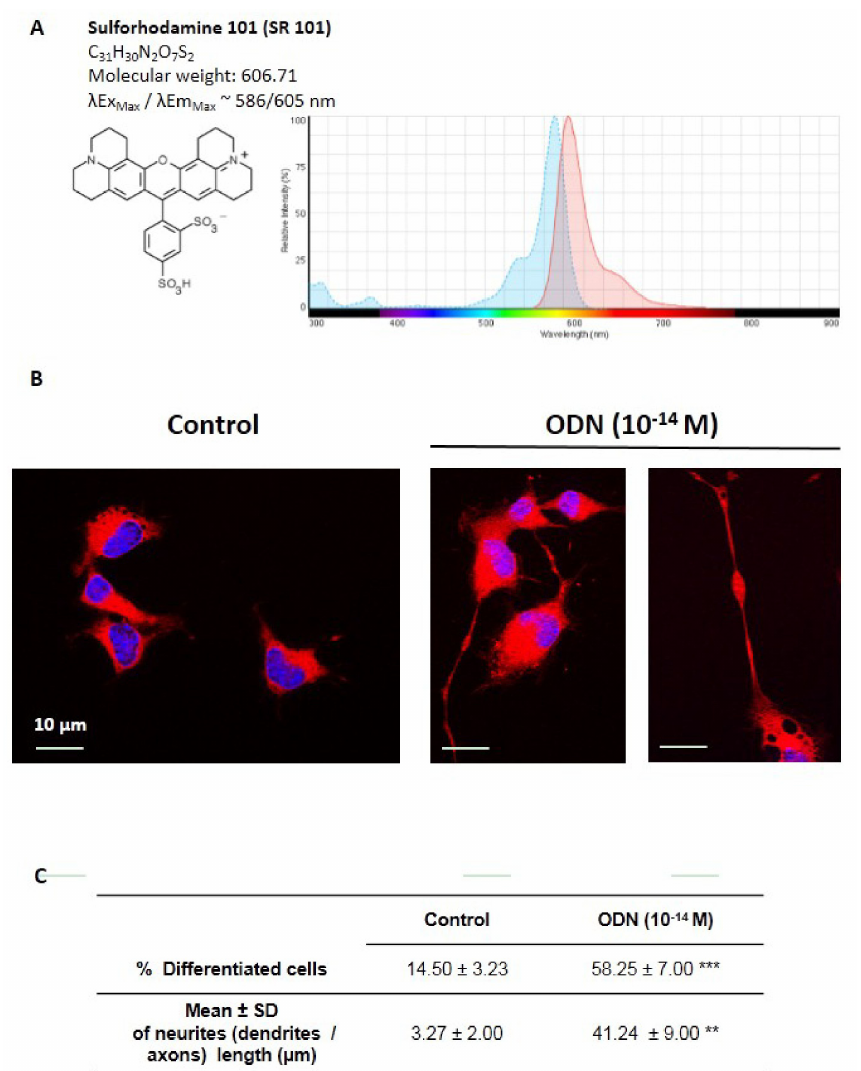
Figure 2. Visualization of neurites (dendrites and / or axons) in ODN-treated N2a cells. Murine neuronal N2a cells were previously cultured for 24 h in conventional cultured medium; N2a cells were further culturedfor48hinmediumwithoutFBSinthepresenceorabsenceofoctadecaneuropeptide(ODN:10 − 14 M). Fixed cells (ethanol 70%; 15 min; 4 ◦ C) were further stained with Sulforhodamine 101 (0.5 µ g / mL; 30 min; 4 ◦ C). The nuclei were counterstained with Hoechst 33342 (2 µ g / mL). ( A ): main characteristics of Sulforhodamine 101 (SR101); ( B ): untreated cells (control); ODN-treated cells, di ff erentiated neural cells with several neurites (long dendrites and / or axons) are observed; ( C ): Table reporting the % of N2a di ff erentiated cells as well as the length of neurites (dendrites / axons) of di ff erentiated cells; the values were obtained on Sulforhodamine 101 (SR101) – stained N2a cells. The images were acquired under a fluorescent microscope coupled with an Apotome (Zeiss). A Mann-Whitney test was used to compare untreated (control) and ODN-treated cells: ** p < 0.01; *** p <